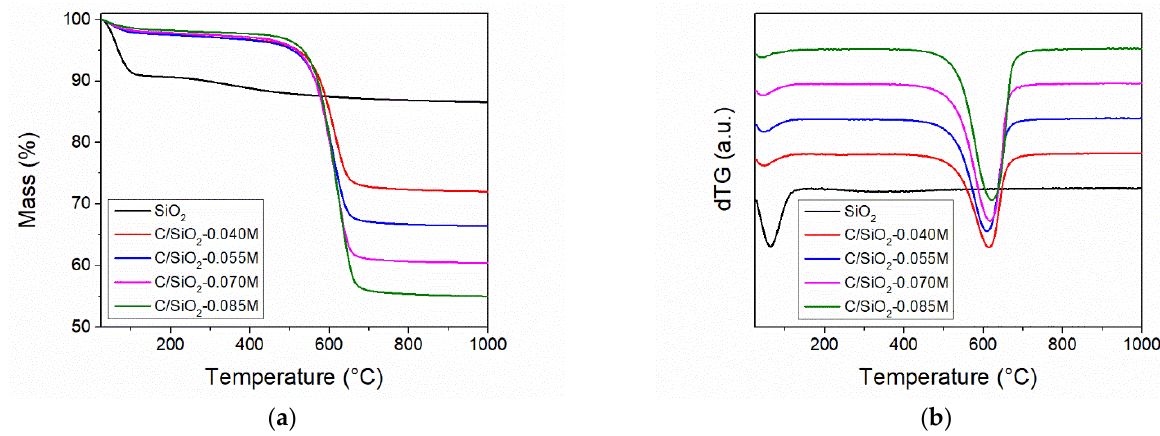
Figure 7. Thermogravimetric ( a ) and derivative thermogravimetry ( b ) analyses of the silica and carbon–silica samples. Table 2. Sample composition based on TGA analyses.